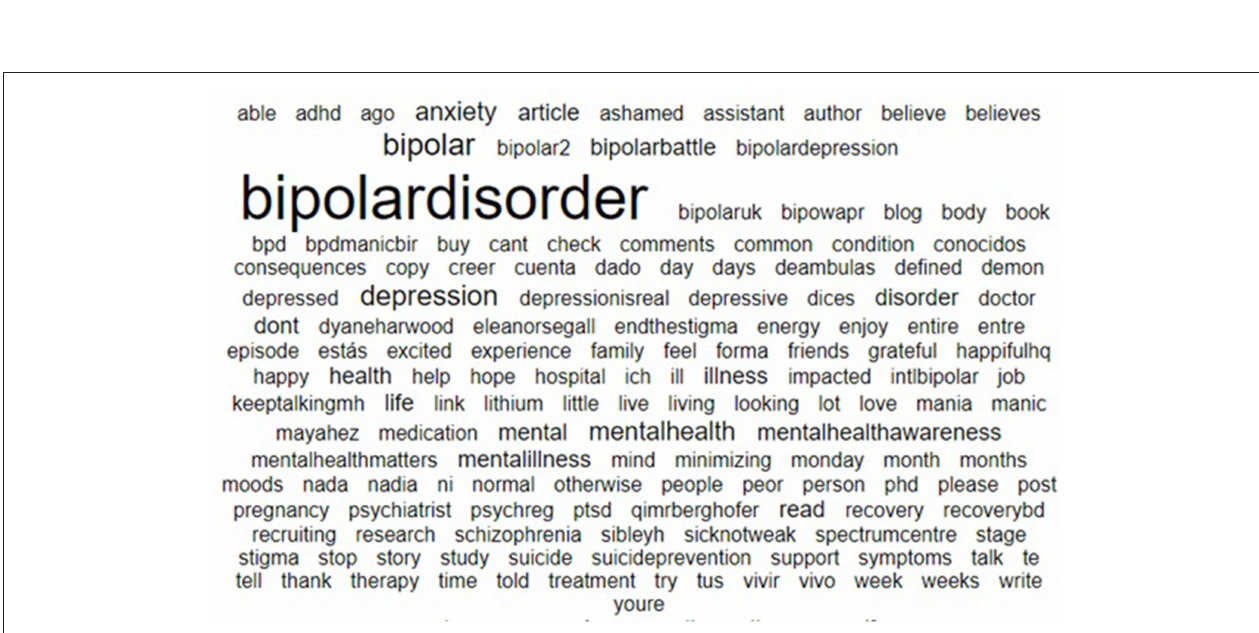
FIGURE A2 | #BipolarDisorder Hashtag Cloud of Census